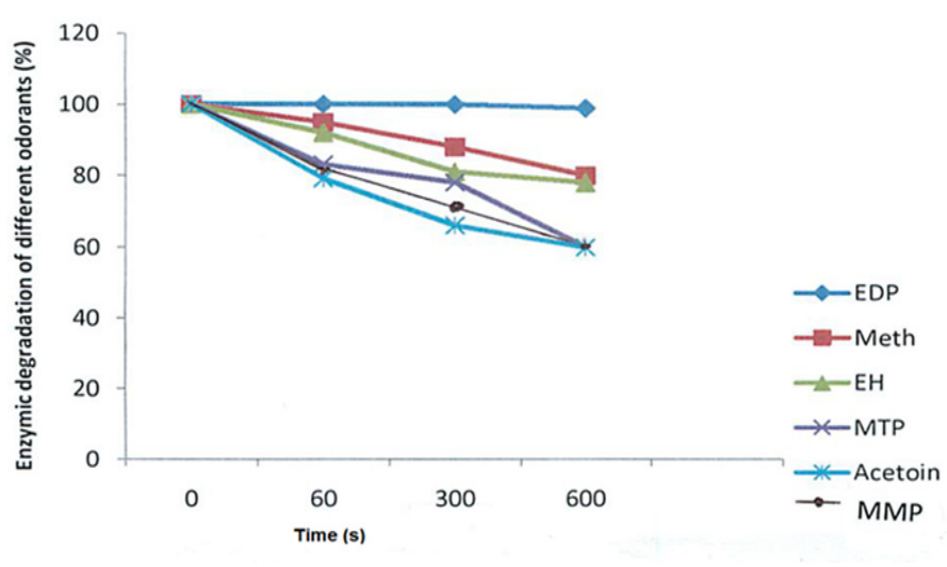
Figure 1. Enzymatic degradation of selected palm wines’ odorants [2-ethyl-3,5- dimethylpyrazine (EDP), methional (Meth), ethyl hexanoate (EH), 3-methylthiol-1-propanal (MTP), 3-mercapto-2-methylpentanone (MMP) and acetoin during incubation with saliva at different time